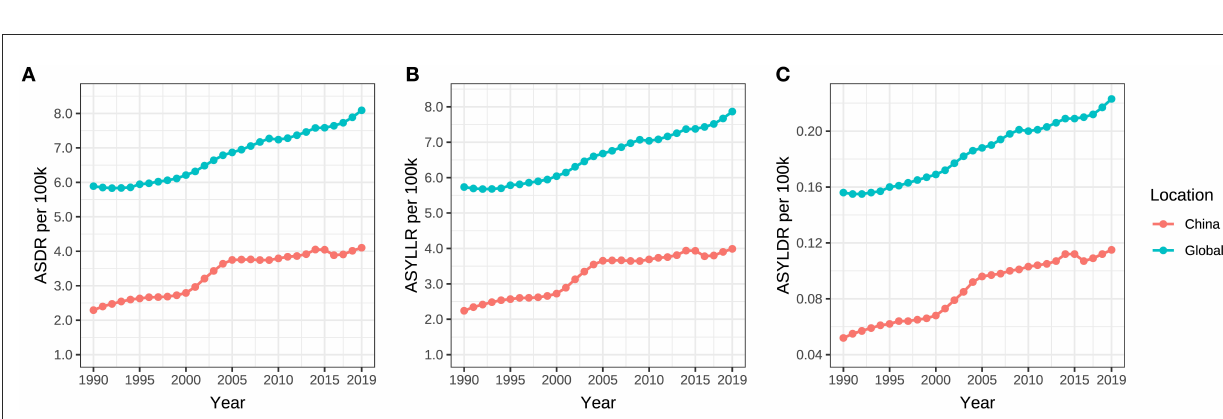
FIGURE5 (A–C) ASDR, ASYLLR, and ASYLDR of ovarian cancer attributable to hyperglycemia from 1990 to